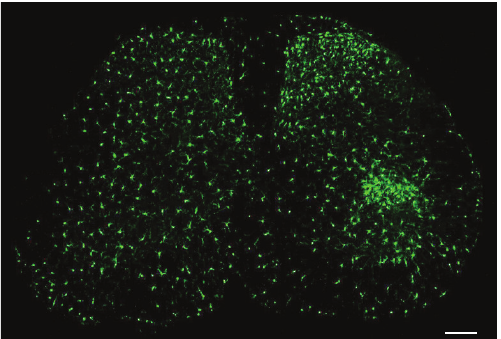
Figure 1: Nerve injury induces marked microglial reaction in the ipsilateral lumbar spinal cord 7 days after chronic constriction injury (CCI). Microglia as demonstrated by CX3CR1 expression in CX3CR1-GFP mice. The contralateral side (left) shows the typicalrestingmicroglialmorphology,andtheipsilateralside(right) illustrates the enlarged and amoeboid morphological features of activated microglia cell bodies. Also note that on the ipsilateral side the number and density of microglia in the medial superficial dorsal horn and lateral ventral horn, where injured primary afferent axons terminate, are significantly increased. Scale, 100 𝜇